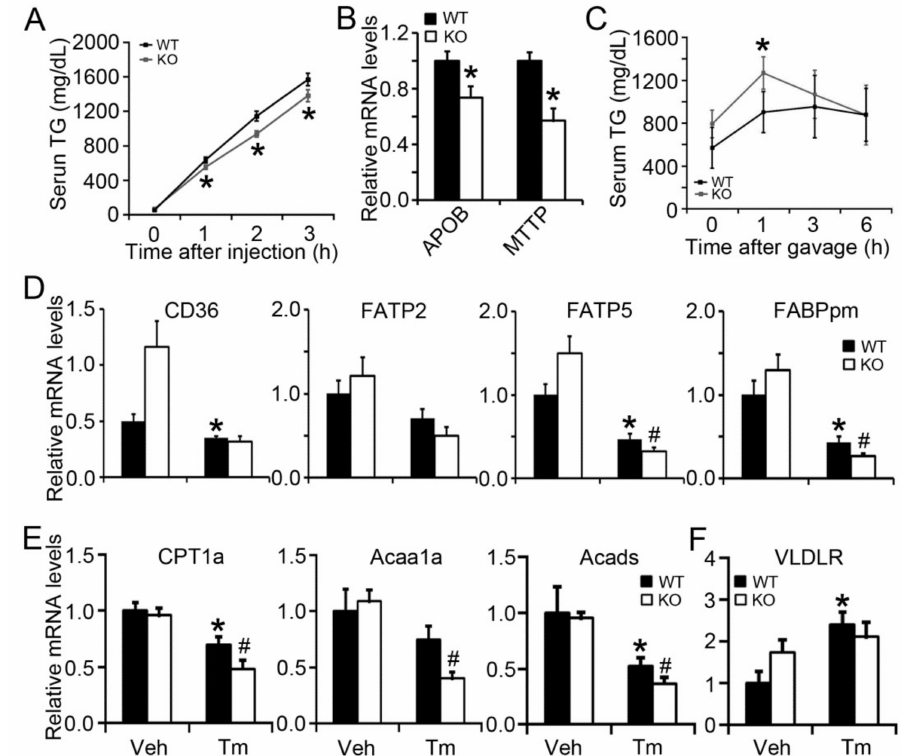
Figure 4. BAP31 deficiency impaired VLDL secretion and exogenous lipid clearance, reduced the gene expression related to fatty acid β -oxidation. ( A ) BAP31 deficiency impaired VLDL secretion. ( B ) BAP31 deficiency decreased APOB and MTTP mRNA levels in mice livers. n = 7 to 8 per group. ( C ) BAP31 deficiency reduced exogenous lipid clearance in mice. n = 6 to 7 per group. *, p < 0.05, KO mice compared with WT mice. The relative mRNA levels of ( D ) CD36 , FATP2 , FATP5 , FABPpm , ( E ) CPT1a , Acaa1a , Acads , and ( F ) VLDLR were determined by quantitative real-time PCR and normalized with 18S rRNA levels. n = 7 to 8 per group. Data represent as mean ± SEM. *, p < 0.05, Tm compared with Veh group. #, p < 0.05, KO compared with WT mice injected with